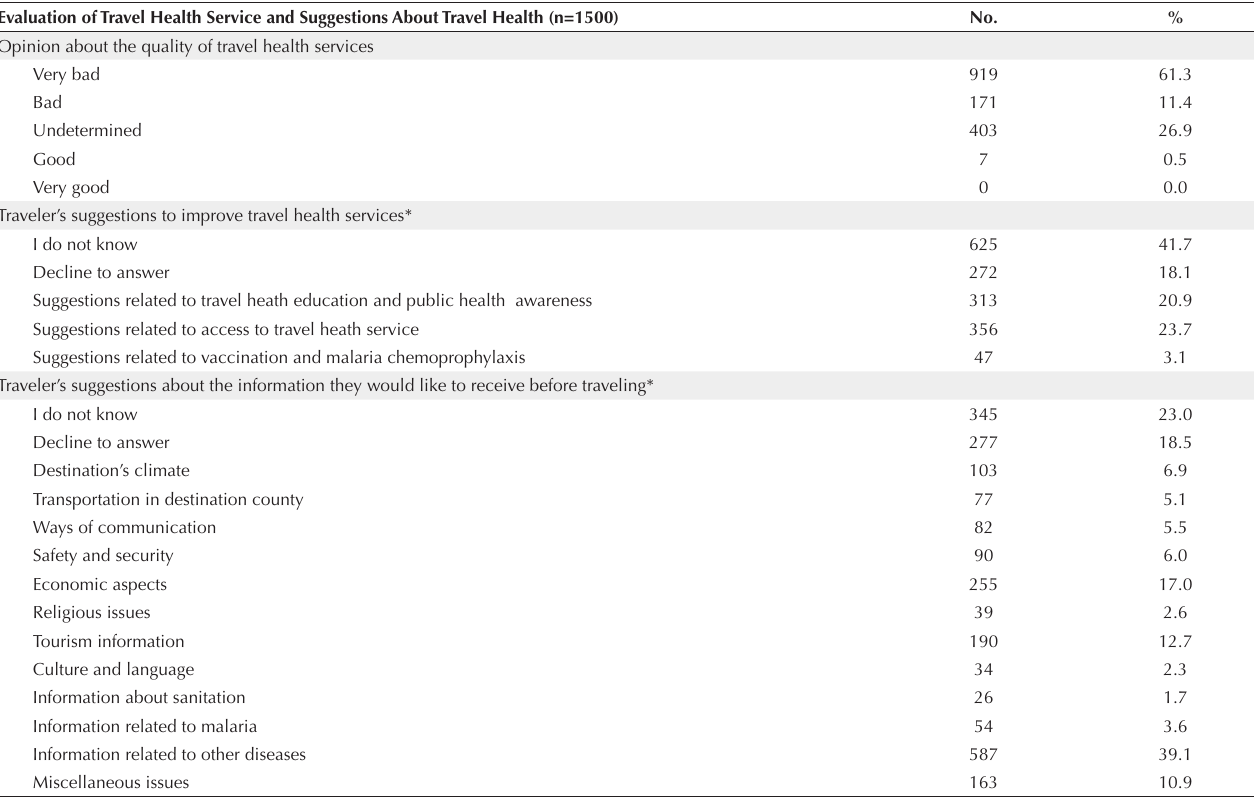
Table 7. Distribution of Travelers at Cairo International Airport According to Evaluation of Travel Health Service and Suggestions About Travel Health Evaluation of Travel Health Service and Suggestions About Travel Health